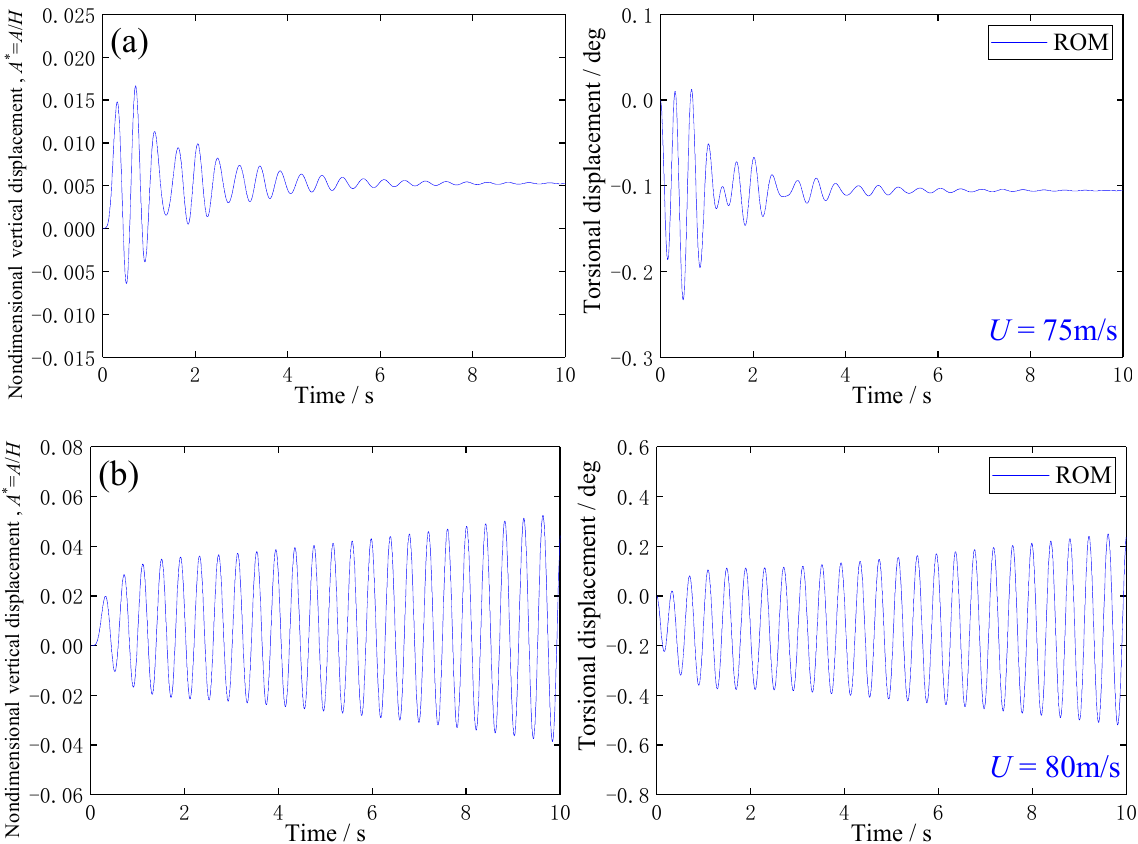
Figure 13. Results of flutter analysis of LDYB based on the ROM method under incoming wind speeds of ( a ) 75 m/s and ( b ) 80 m/s for the prototype main deck section, respectively.